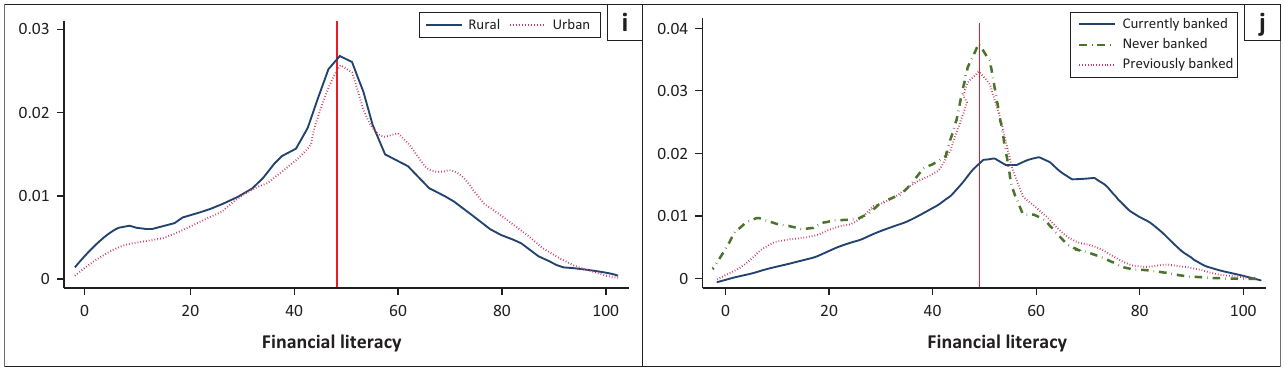
FIGURE 1-A4 (Continues...): The distribution of financial literacy scores in South Africa by the individual’s characteristics (pooled sample): (a) Financial literacy by gender, (b) age group, (c) race, (d) education level, (e) income level, (f) occupation, (g) marital status, (h) province, (i) geo-area and (j) banking